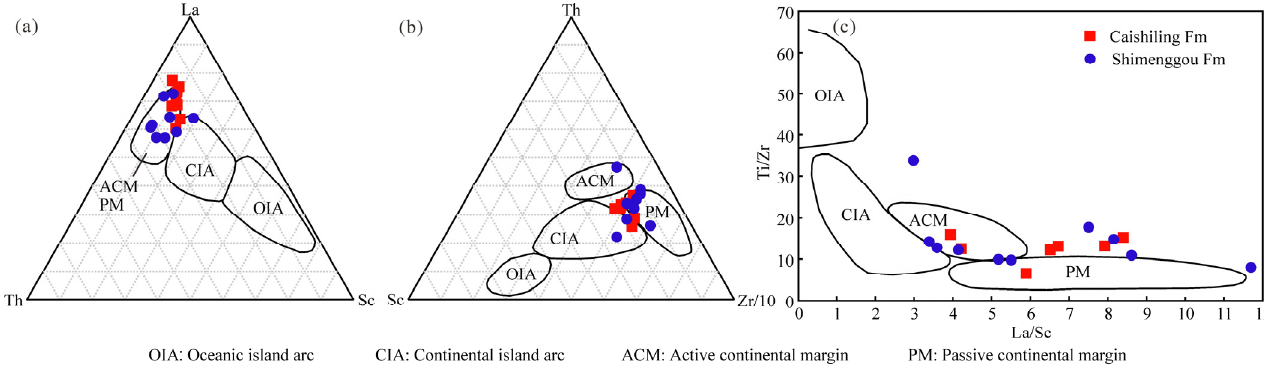
Figure 7. A trace element discrimination map of tectonic environment of Jurassic sandstones in Yuqia uranium occurrences (modified after [32]). ( a ) La–Th–Sc diagram, ( b ) Th–Sc–Zr/10 diagram, ( c ) La/Sc–Ti/Zr diagram.